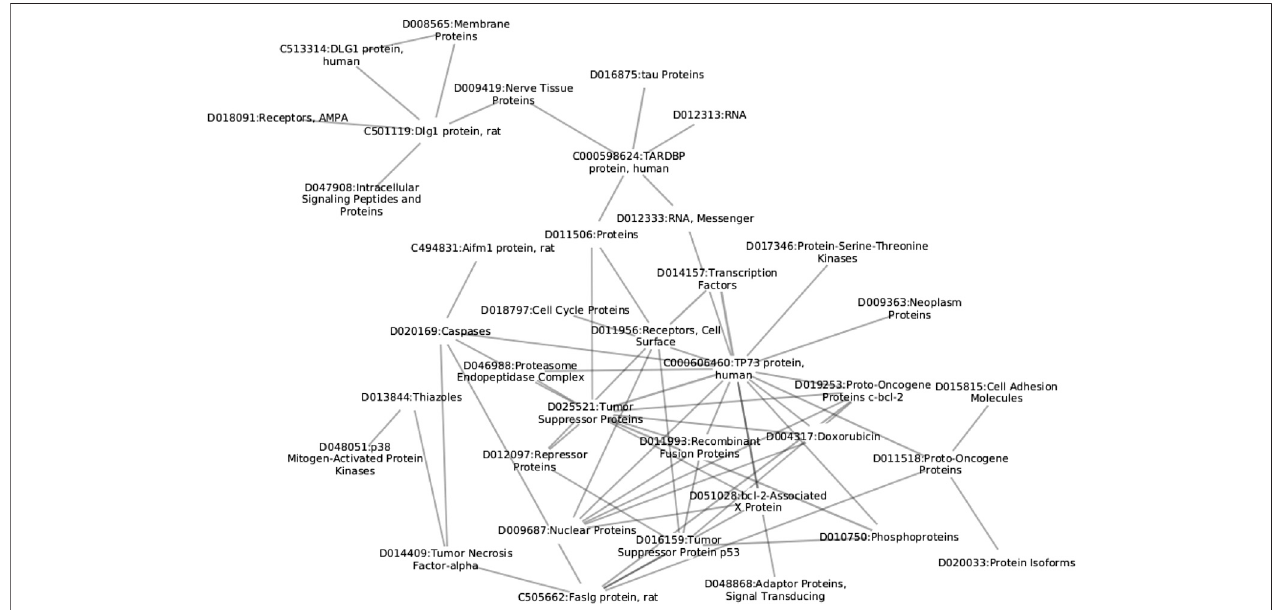
FIGURE 2 | Example of MeSH chemical term subnetwork. The reader can observe different levels of information all interlinked within the same structure; from the cellular level (D018797), to protein level (C000598624).